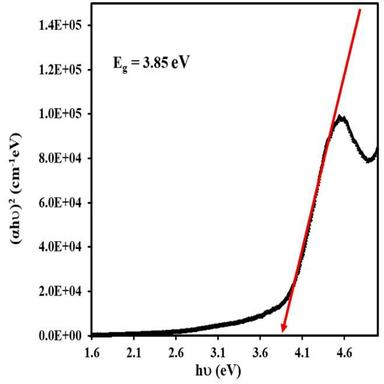
Tauc plot and estimation of the band gap (Eg) of CuO NPs dispersed in chloroform.